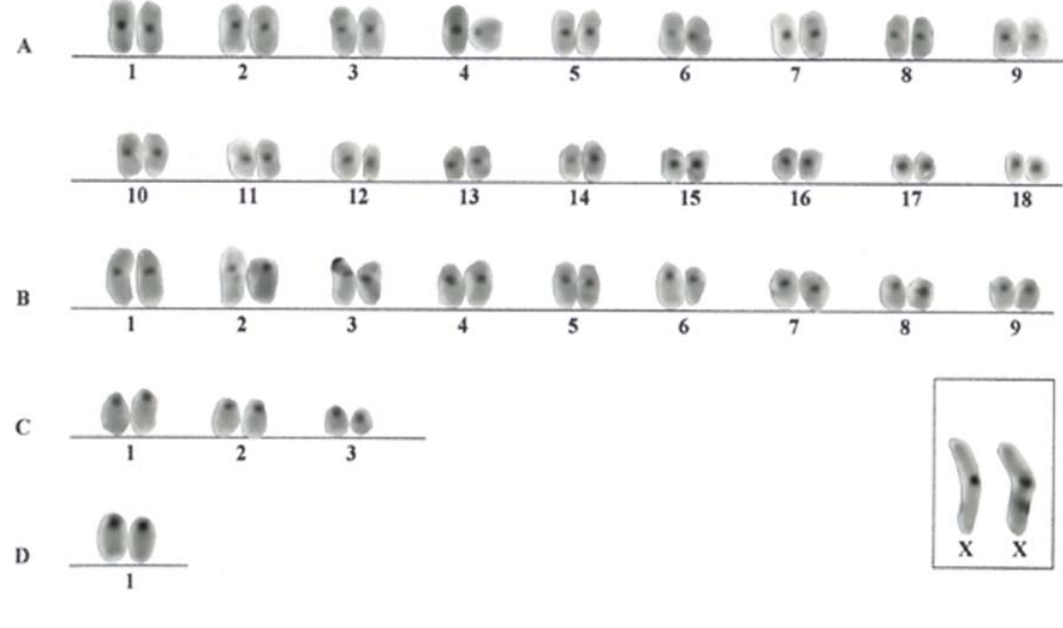
Fig. 6 – Banding C (CBG) standard of the lineage 2n=64 of D. fuliginosa .